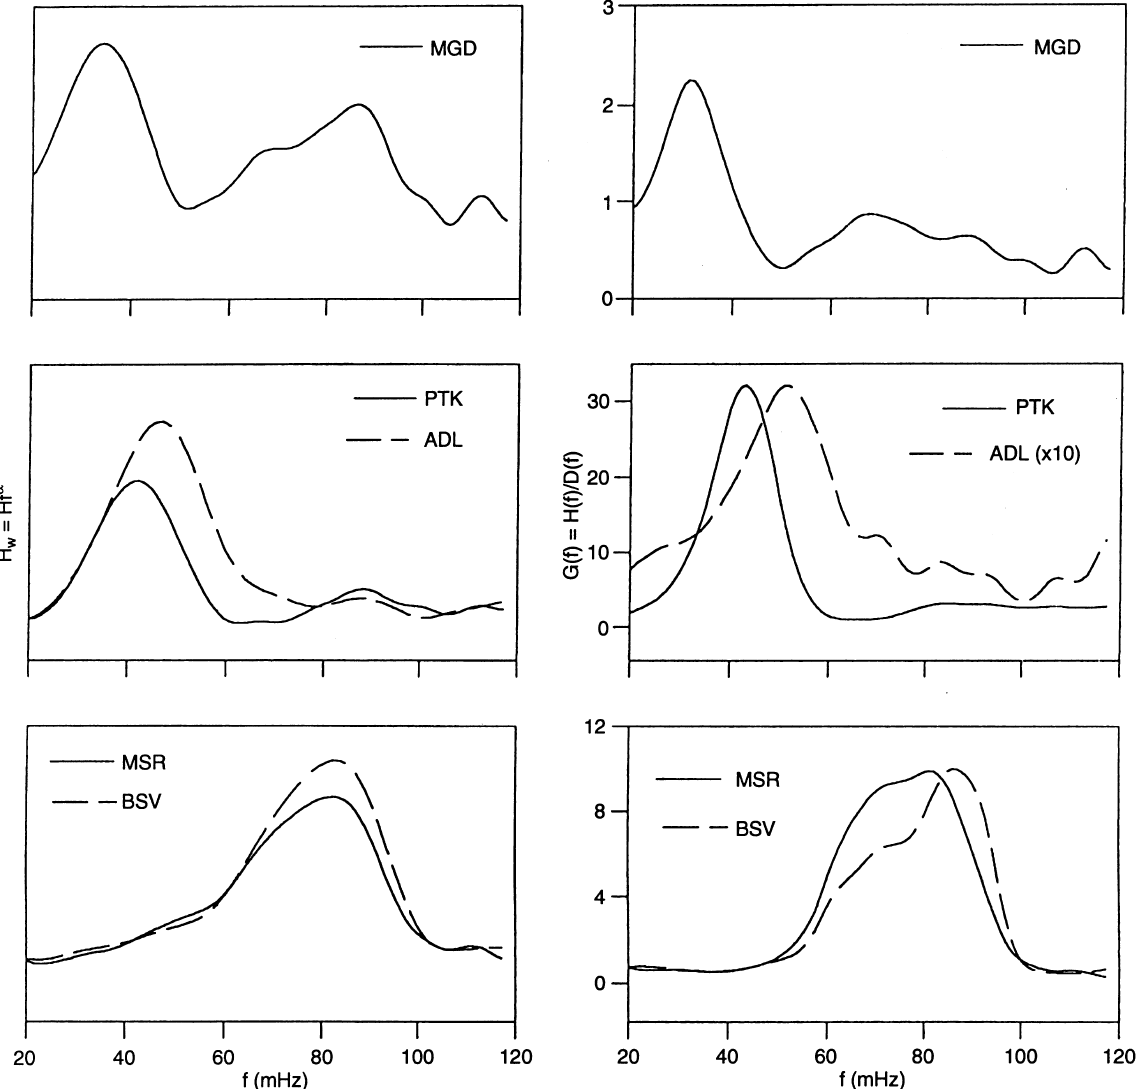
Fig. 3. Amplitude spectra of H -component (in arbitrary units) for the event 1 with corrected background slope ( H w (cid:133) f (cid:134) (cid:136) H (cid:133) f (cid:134) (cid:1) f a ( left panel ), and the H (cid:133) f (cid:134) = D (cid:133) f (cid:134) spectral density ratio ( right